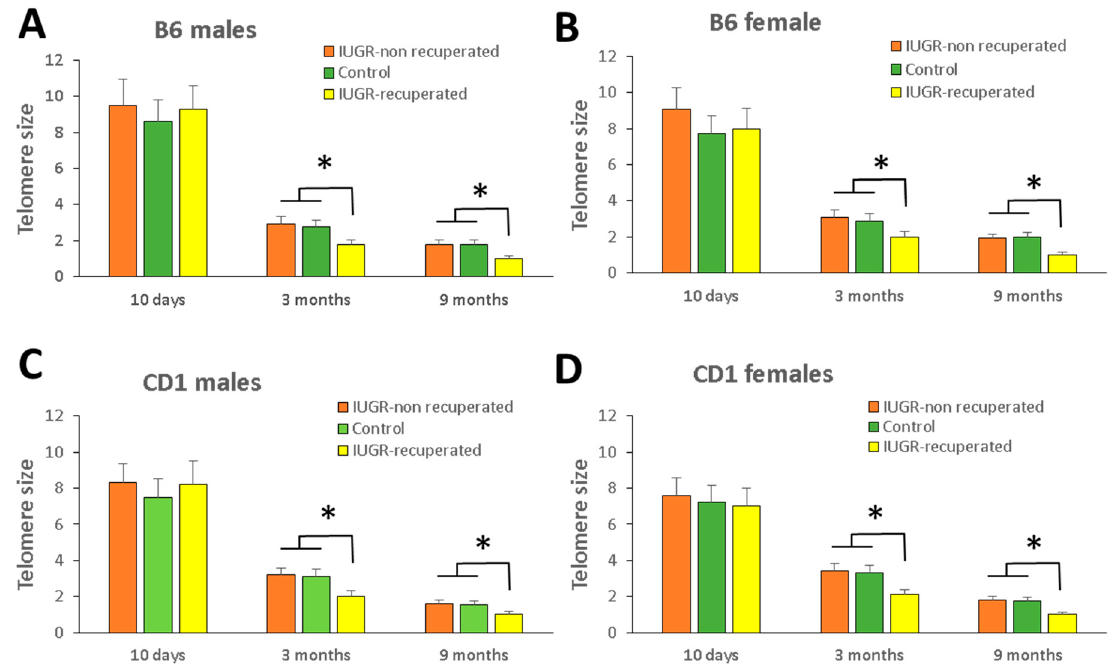
Figure 2. Relative telomere length. Telomere size determined at 10 days, 3- and 9-months of age in mice of strains B6 ( A , B ) and CD1 ( C , D ) with IUGR and controls of both sexes. Note that at 3- and 9 months of age, both in male and female mice, the IUGR animals reaching the weight of control animals (IUGR-recuperated) have a shorter telomere length than the other groups. Results provided as the mean ± SD. *, p < 0.05 versus control and IUGR-non recuperated mice.